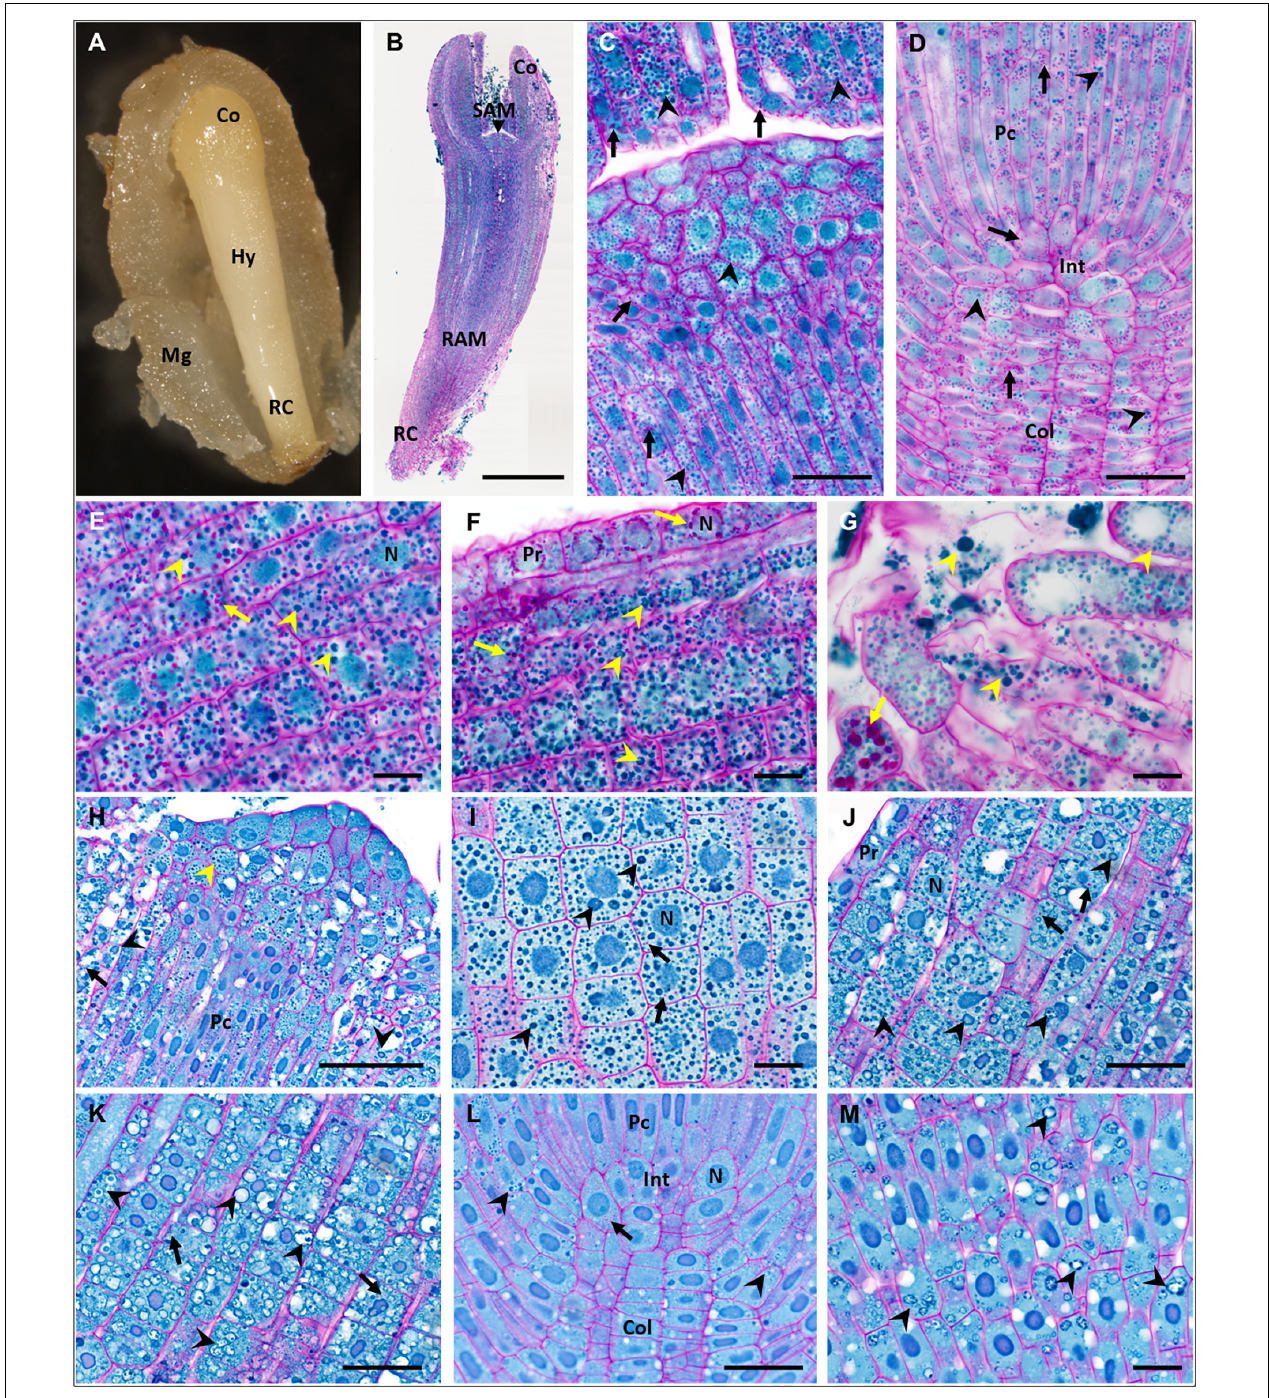
FIGURE 3 | Accumulation of storage compounds in fresh and dry zygotic embryos (ZEs) of P. abies . (A–G) fresh ZE (ZEf); (H–M) dry ZE (ZEd). (A) Morphology of a ZEf in a megagametophyte. (B) Longitudinal paraffin section of a ZEf stained with PAS/amido black (polysaccharides in cell walls and starch grains stained magenta, proteins in nuclei and protein storage vacuoles (PSVs) stained blue). (C) Detail of the shoot apical meristem and part of the cotyledons in panel (B) ; starch grains (arrows) and PSVs (arrowheads) were abundant in all types of cells. (D) Detail of the root apical meristem in panel (B) ; numerous starch grains (arrows) and PSVs (arrowheads) occurred in all cells of the procambium, root initials and columella. (E) Detail of the hypocotyl cortex in panel (B) proximal to cotyledons; numerous starch grains (arrows) and intact PSVs (arrowheads) occurred in all cells. (F) Detail of protodermal and cortical cells of the basal part of the hypocotyl in panel (B) ; numerous starch grains (arrows) and PSVs (arrowheads) occurred in all cortical cells; starch grains surrounded nuclei in protoderm. (G) Detail of the most distal cells